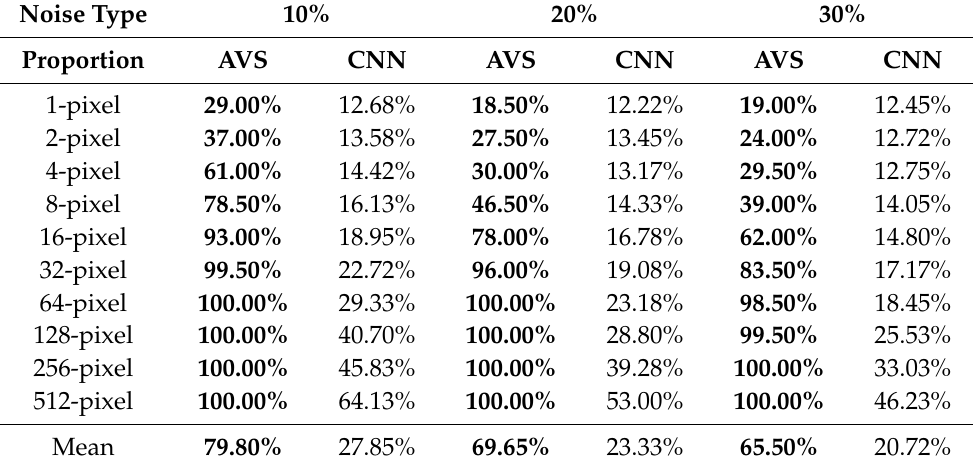
Table 4. The experimtental results of AVS and CNN under the dynamic background